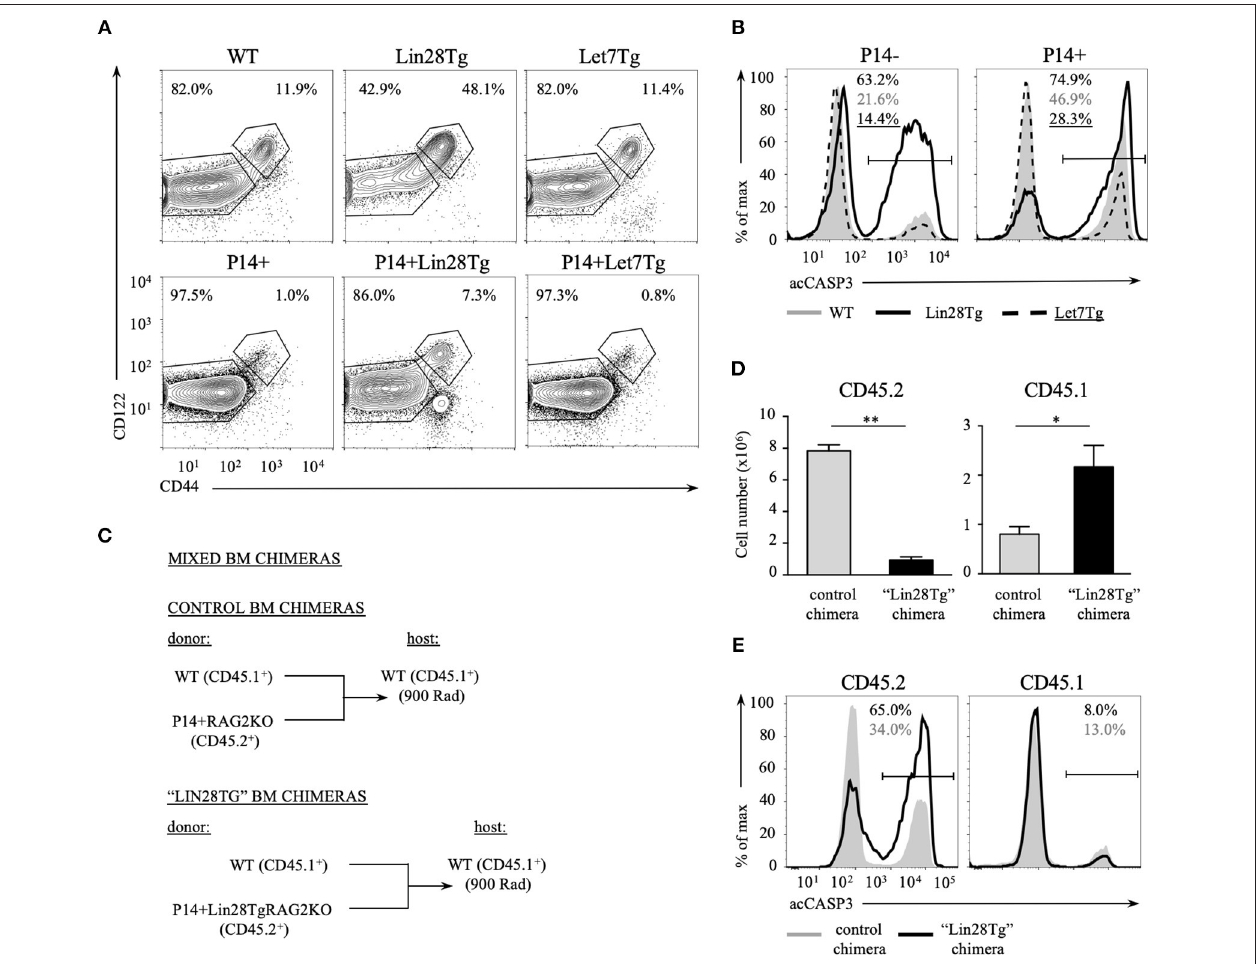
FIGURE 3 | Impaired survival of let-7-deficient T cells is cell-intrinsic. (A) Surface expression of CD44 and CD122 memory markers on CD8T cells from lymph nodes of polyclonal (top) and P14 + Rag2KO (bottom) wild type, Lin28Tg and Let7Tg mice. (B) Intracellular staining for active Caspase-3 in CD8 lymph node T cells from polyclonal (left) and P14 + Rag2KO wild type, Lin28Tg and Let7Tg mice (right) cultured for 12h in media at 37 ◦ C. (C) Schematic representation of the generation of mixed bone marrow chimeras. (D) Total number of CD45.2 + and CD45.1 + CD8 lymph node T cells recovered from control ( n = 3) and “Lin28Tg” ( n = 3) mixed BM chimeras. Data are displayed as mean ± SEM, * p < 0.05, ** p < 0.01. (E) Intracellular staining for active Caspase-3 in the same populations of CD8 lymph node T cells cultured for 18h in media. Data in (A,B,E) are representative of three independent staining